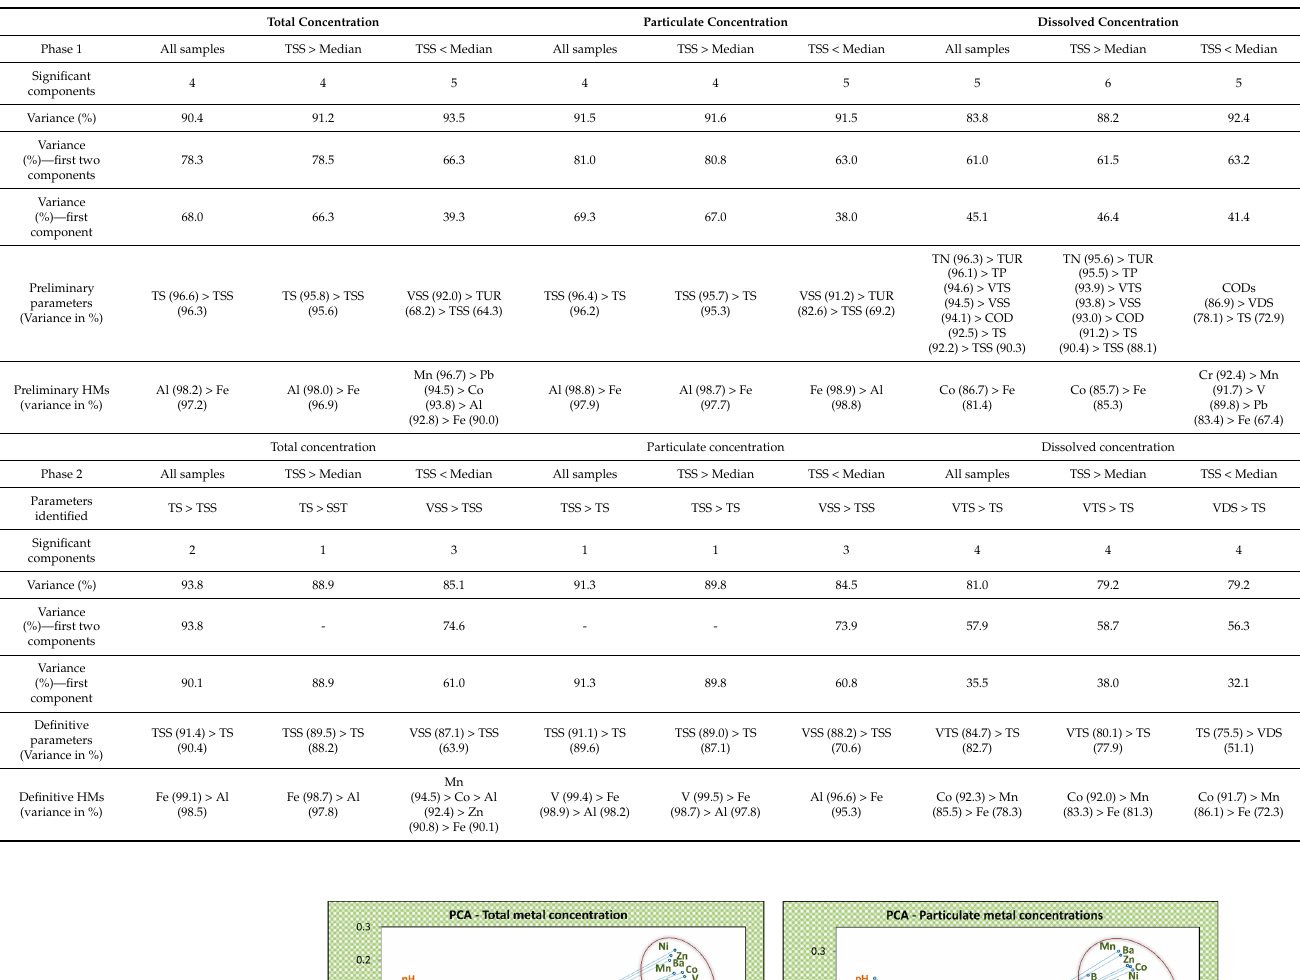
Table 5. PCA results for concentrations of conventional parameters and HMs under scenarios of higher- and lower-energy runoff events.